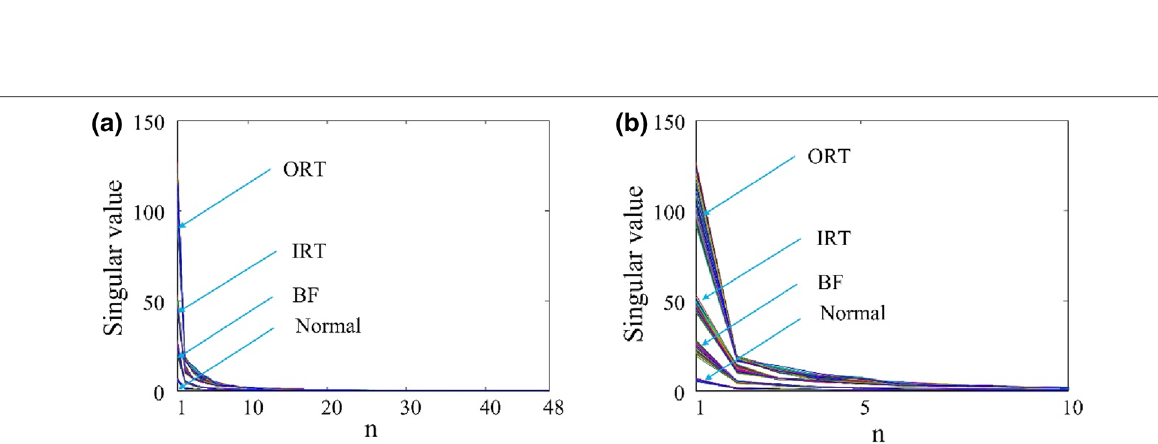
Figure 12 Singular value clusters for different operating states: ( a ) first 48 order; ( b ) first 10 order